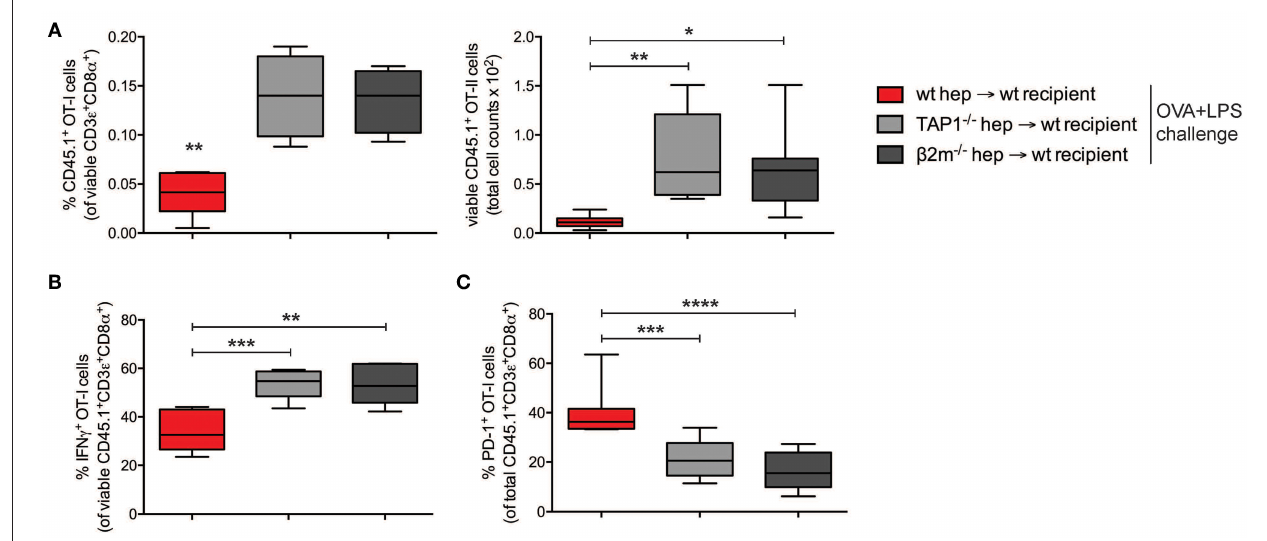
FIGURE 5 | CD8 + T cell tolerance is the result of hepatocyte-dependent antigen cross-presentation. (A) Frequency (left) and total cell number (right) of viable CD3 ε + CD8 α + CD45.1 + OT-I cells were analyzed by flow cytometry after harvesting from the dLNs of recipient CD45.2 + C57BL/6 mice infused with either wt hepatocytes, TAP1 − / − or β 2m − / − hepatocytes ex vivo incubated with pGal-OVA (12.5 µ M) according to the schedule described in Figure 4B . (B) Viable CD3 ε + CD8 α + CD45.1 + OT-I cells harvested from the dLNs of recipient CD45.2 + C57BL/6 mice treated as in (A) were stained intracellularly for IFN- γ after ex vivo restimulation with OVA 257 − 264 (SIINFEKL) and analyzed by flow cytometry. (C) Viable CD3 ε + CD8 α + CD45.1 + OT-I cells were stained for PD-1 after harvesting from the dLNs of recipient CD45.2 + C57BL/6 mice treated as in (A) and analyzed by flow cytometry. * P < 0.05, ** P < 0.01, *** P < 0.001, **** P < 0.0001 (unpaired